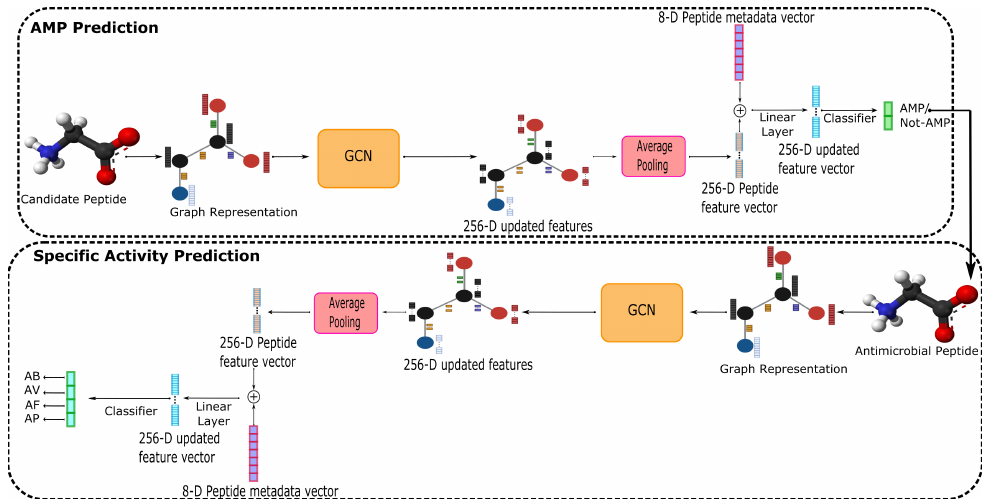
Figure 3. AMPs-Net overview. The FASTA sequence of a candidate peptide was transformed into a graph representation and used as input to a Graph Convolutional Neural Network. Based on the message-passing algorithm, a 256-Dimensional updated graph was obtained and averaged over the feature dimensions. The representative vector was concatenated with the physicochemical properties of the peptide, and a linear layer was then used to classify the peptide into an AMP or Non-AMP. Peptides predicted as AMPs were further analyzed by a similar network that outputs the probability of finding them within the four sub-classes of antimicrobial